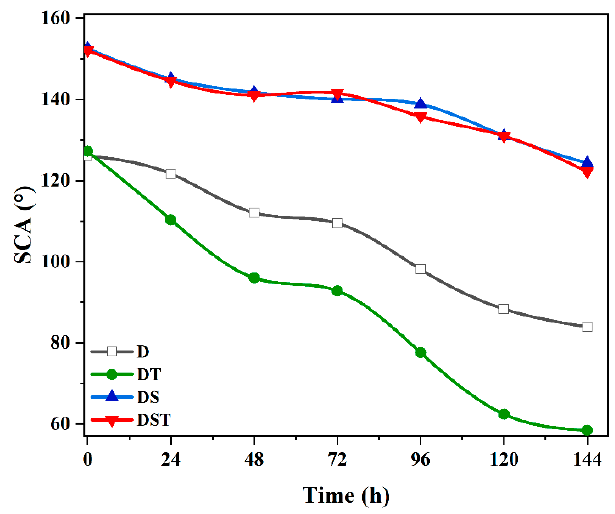
Figure 9. Variation in static contact angles during the UVA ageing test.